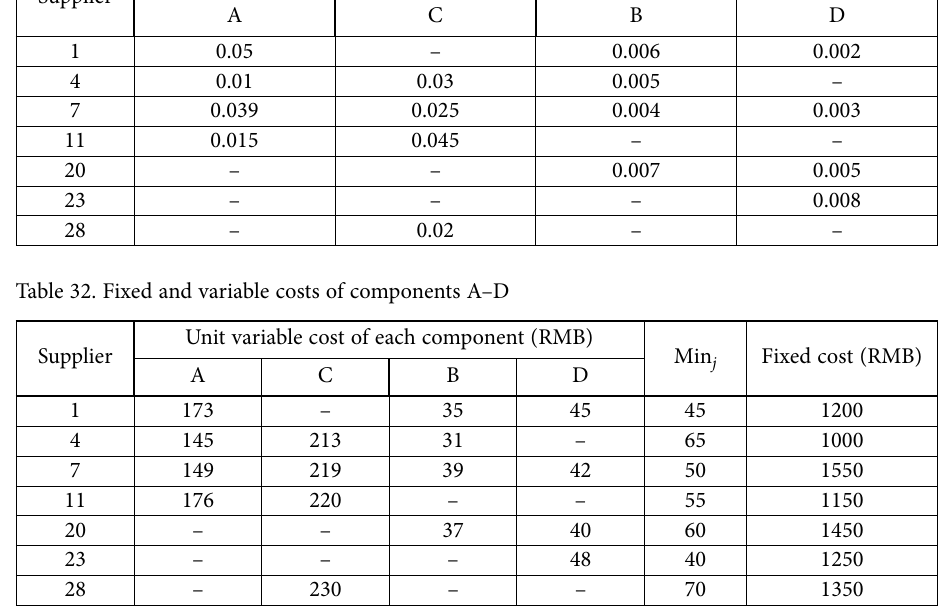
Note: Min j – The minimum order quantities for component if purchasing from supplier j . Table 33. Triangular fuzzy lead times for components A–D